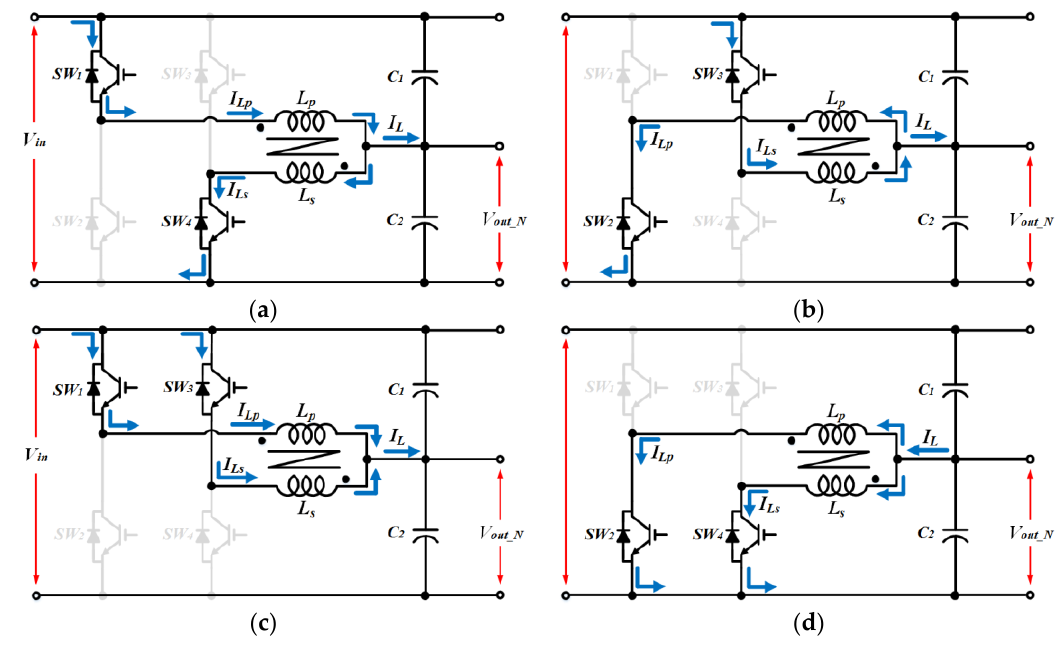
Figure 4. Switching patterns and current flow path of the proposed VB: ( a ) Mode 1; ( b ) Mode 2; ( c ) Mode 3; ( d ) Mode 4.